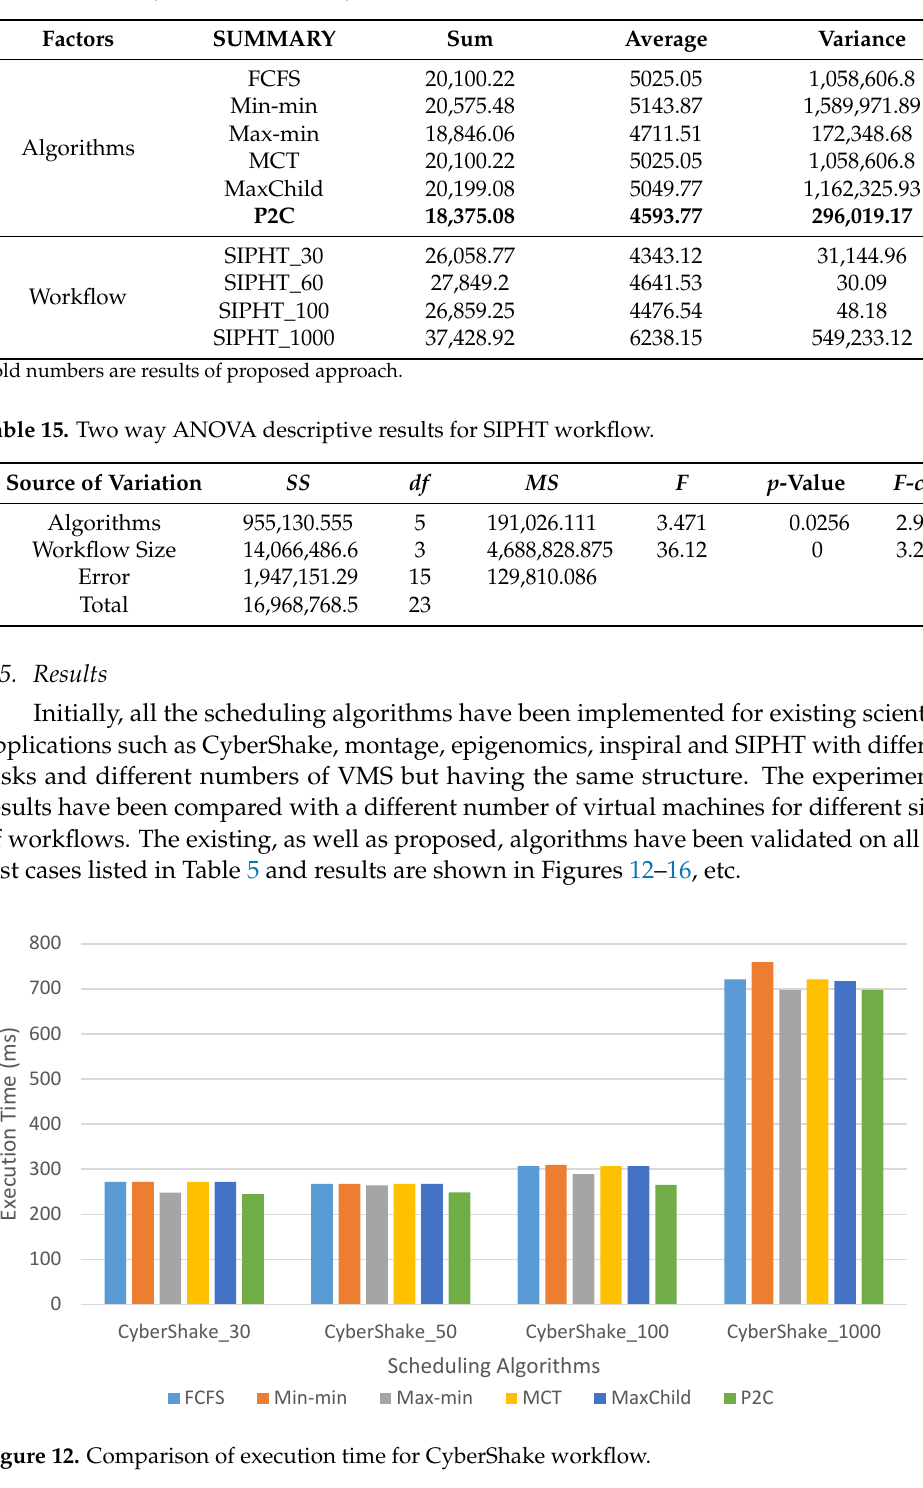
Table 14 indicates that total and average execution time of SIPHT Workflow for the pro- posed P2C algorithm is less compared to other comparative scheduling algorithms. Since the p -Value for the factor Algorithm (0.025 < 0.05) or ( F = 3.471 > 2.901 = F-crit ) as depicted